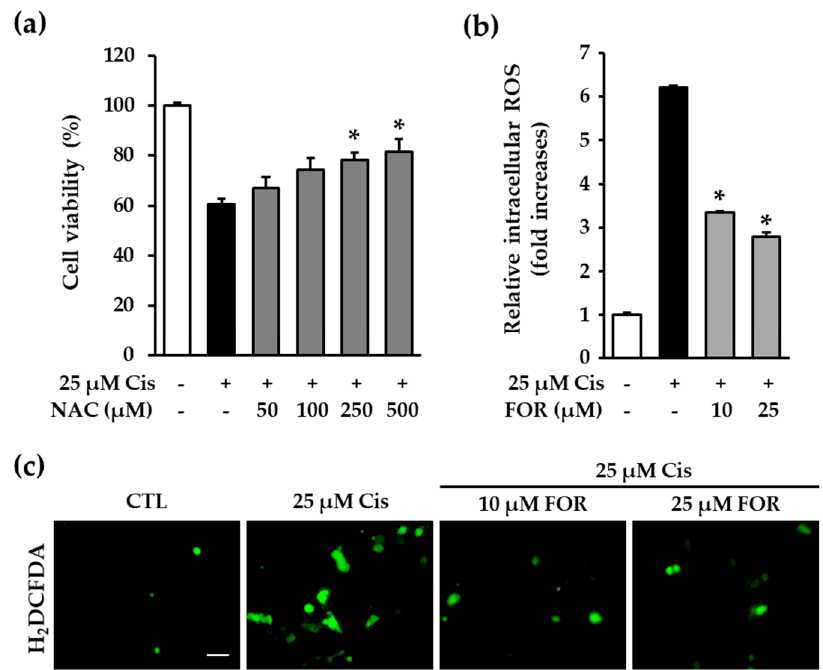
Figure 4. Formononetin inhibits cisplatin-induced oxidative stress. ( a ) LLC-PK1 cells were treated with 25 μ M cisplatin in the presence or absence of the NAC and carried out cell viability assay. Bars denotes the percentage of cell viability (mean ± S.E.M., * p < 0.05 compared with cisplatin-treated cells); ( b ) LLC-PK1 cells exposed to 25 μ M cisplatin for 24 h with formononetin followed by staining cells with H 2 DCFDA. Bar graphs depict the fold increases in the intracellular ROS (mean ± S.E.M., * p < 0.05 compared with cisplatin-treated cells); ( c ) fluorescence microscopic images indicated the intracellular ROS accumulation. Green color indicates DCF-positive cells. Scal bar, 50 μ m.